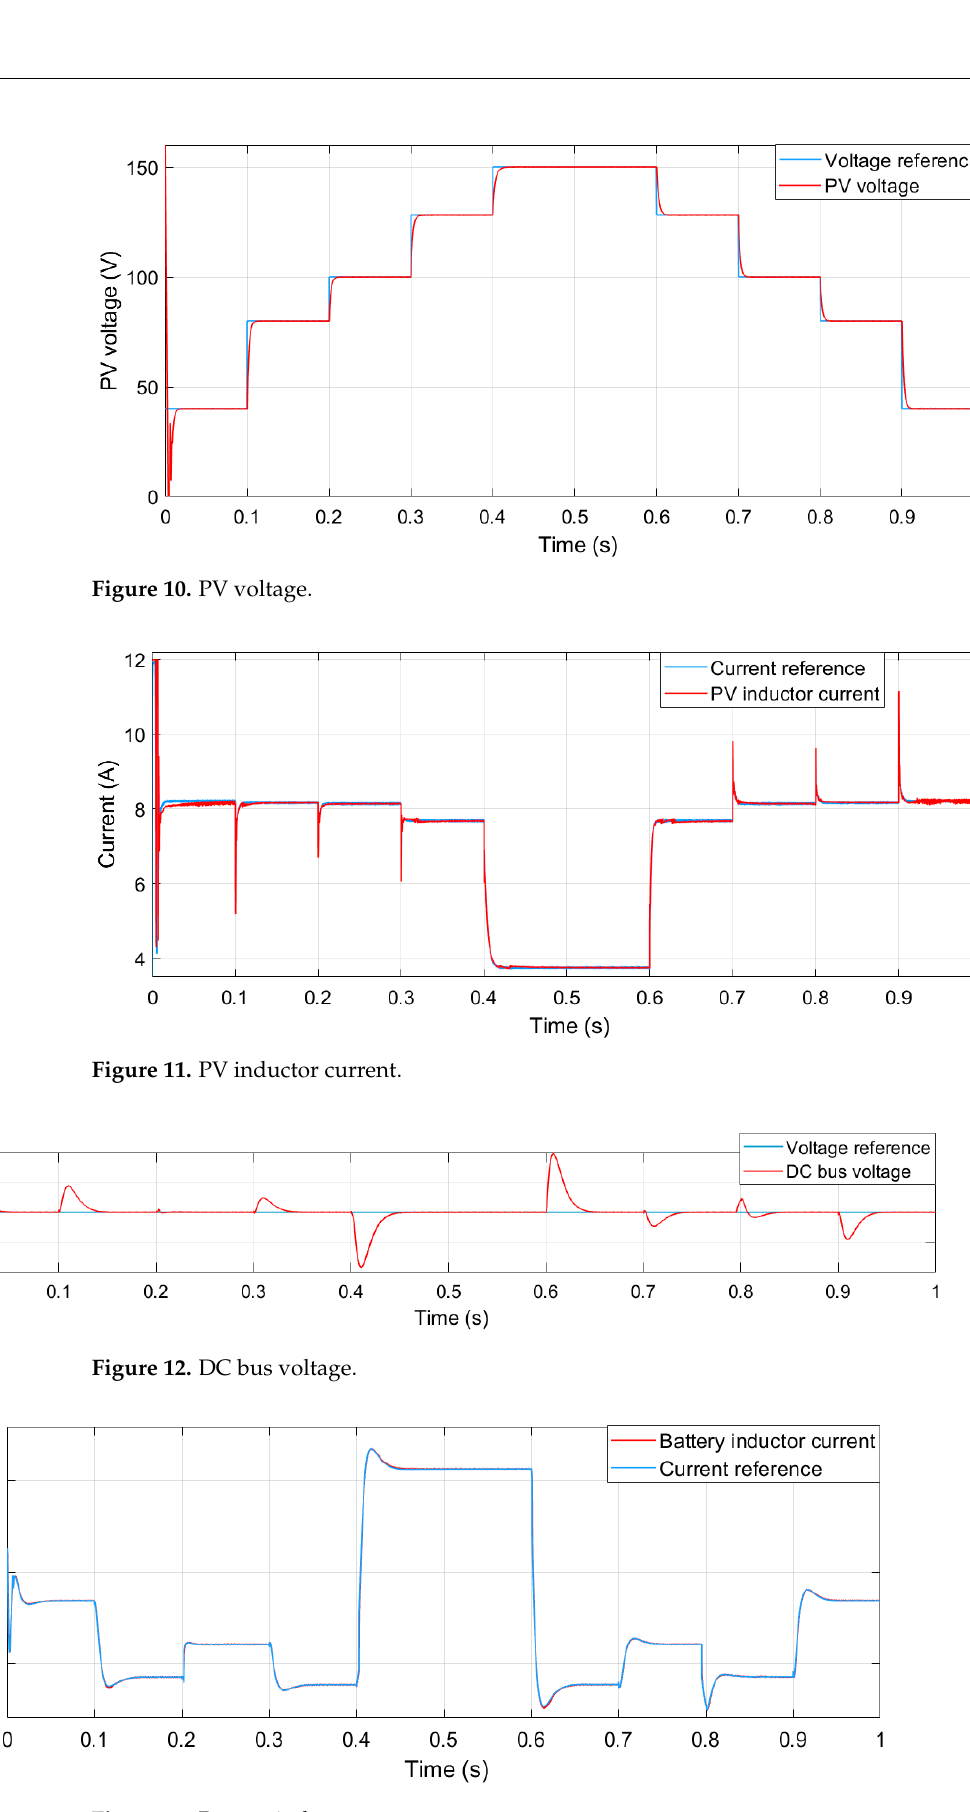
Figure 13. Battery inductor